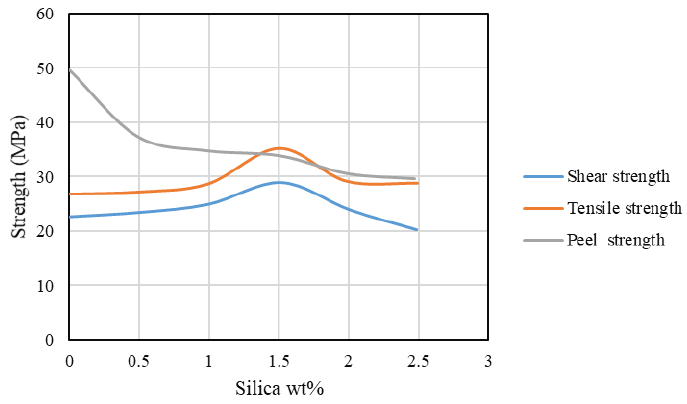
Figure 14. Effect of filler content on joint strength. Adapted from [117].